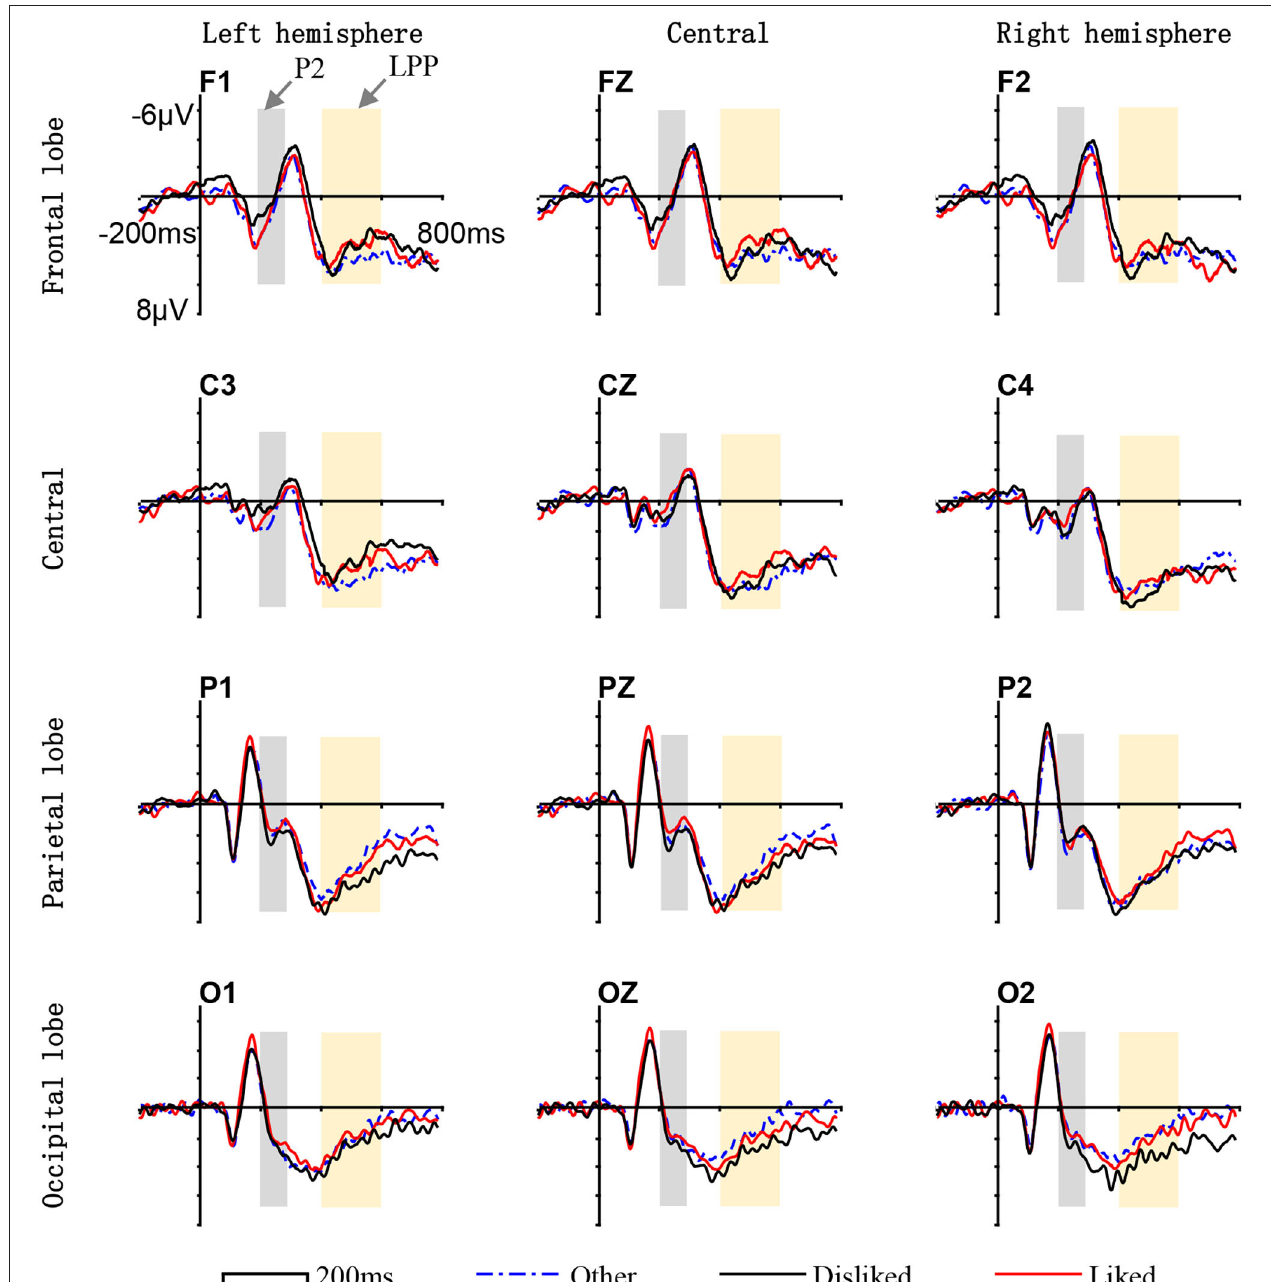
FIGURE 4 | The average ERP waveform for liked/disliked/other interfaces within different scalp areas in different post-stimulus onset time windows. No significant ERP difference for stimuli of different preferences was found in the 150–200 ms time window from the frontal-central or parietal-occipital regions. Significant P2 (marked as gray) differences for stimuli of different preferences from the frontal-central and parietal-occipital areas were found in the 200–300 ms time window. Significant LPP (marked as light yellow) differences for stimuli of different preferences from the frontal-central and parietal-occipital areas were found in the 400–600 ms time window. The x-axis indicates the time and the y-axis indicates the